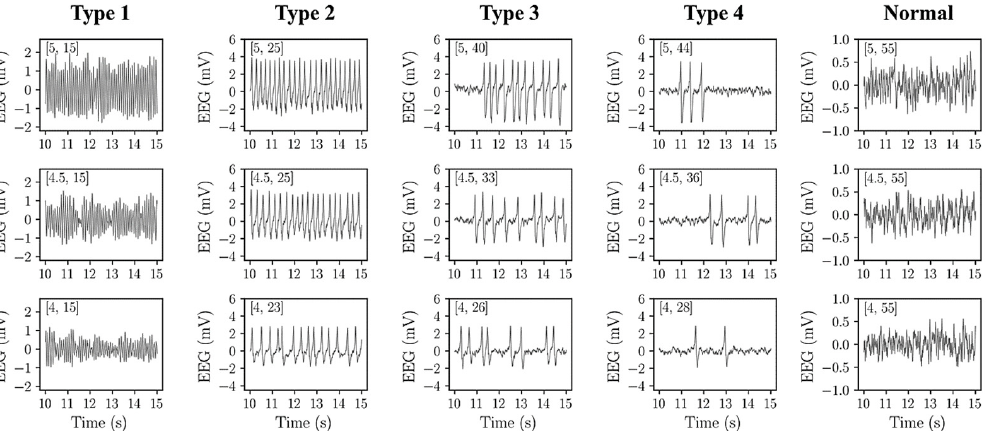
Figure A1. EEG segments produced by changing the values of A and B (in the square brackets) in the mathematical model to represent normal and four types of epileptiform discharges. Each combination of parameters was used to produces 50 EEG segments of 5 s.